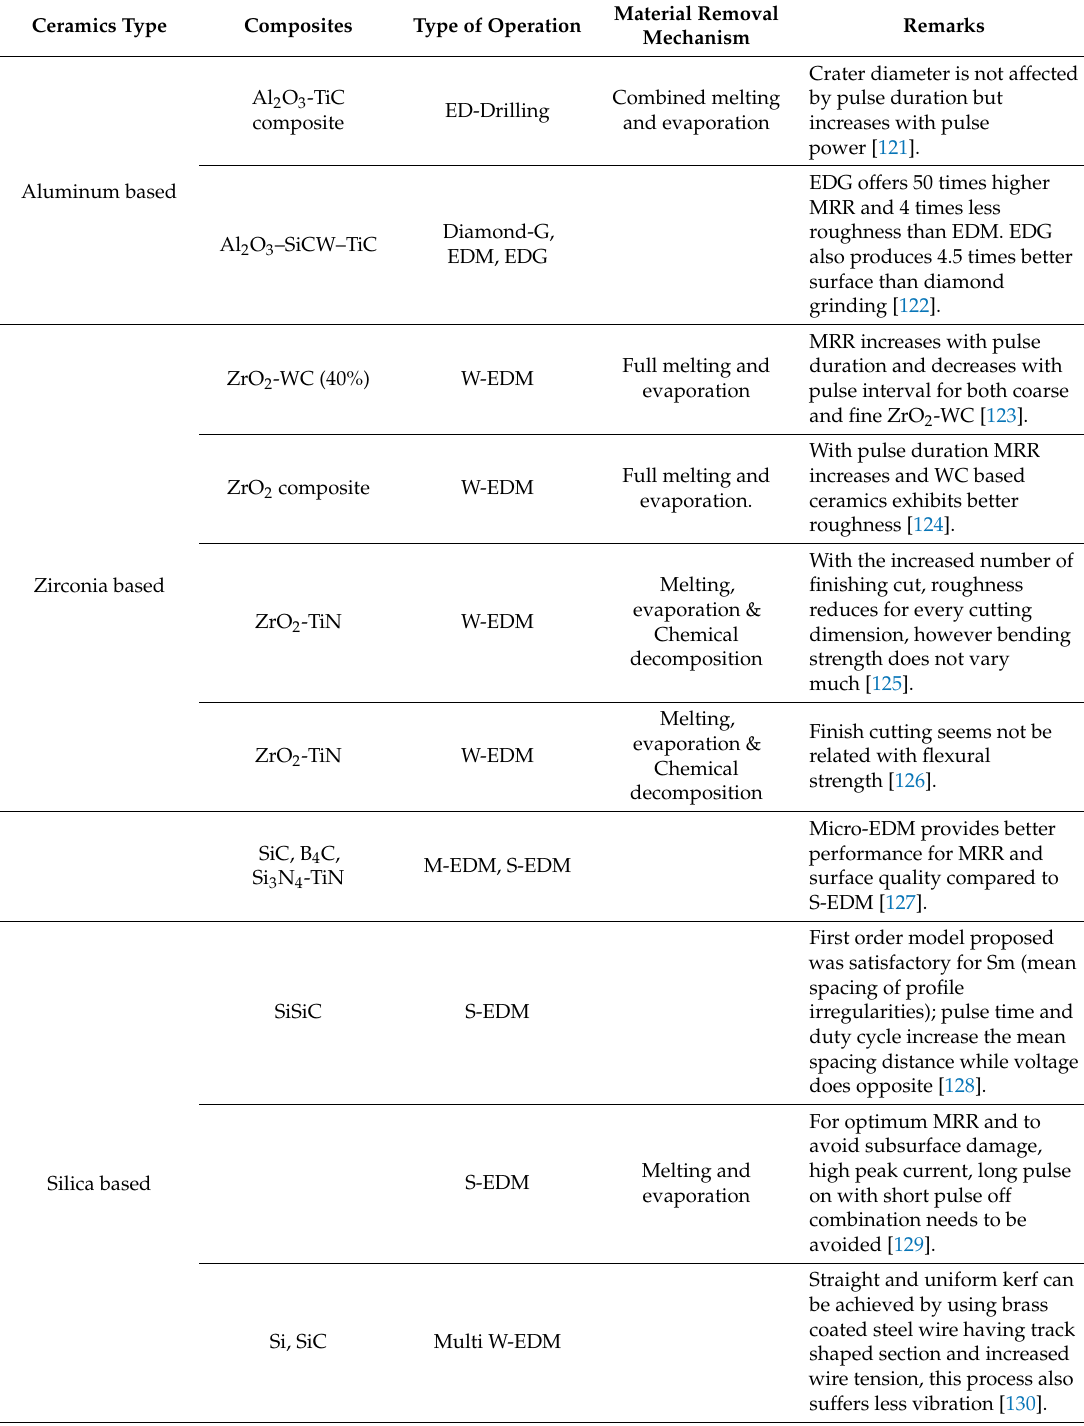
Table 3. Summary of EDM of conductive